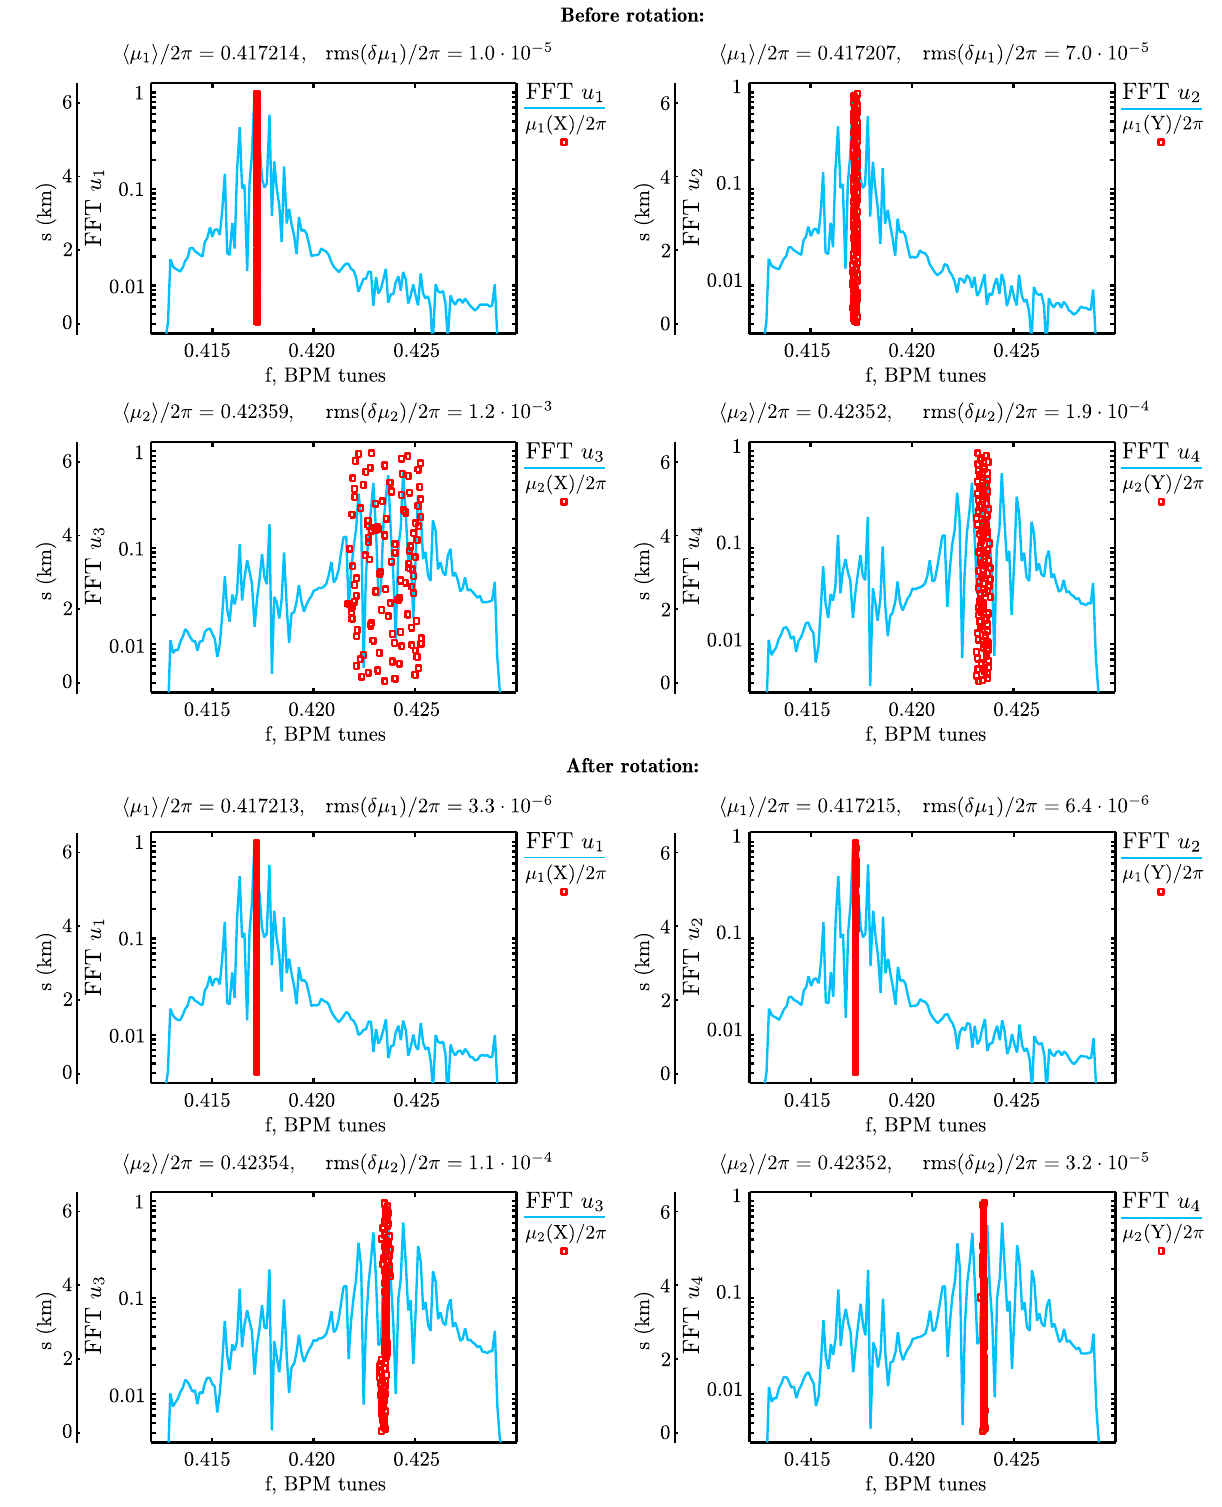
ð X Þ —betatron tune (cid:6) . (cid:6) calculated at 2 1 1